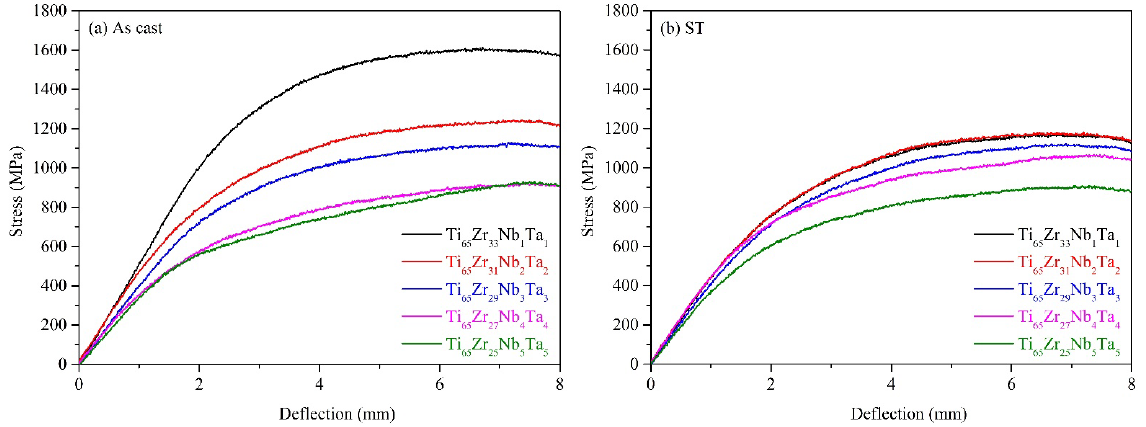
Figure 6. Stress–deflection curves of the Ti–Zr–Nb–Ta MEAs obtained through three-point bending tests under various conditions: ( a ) as cast and ( b ) ST.